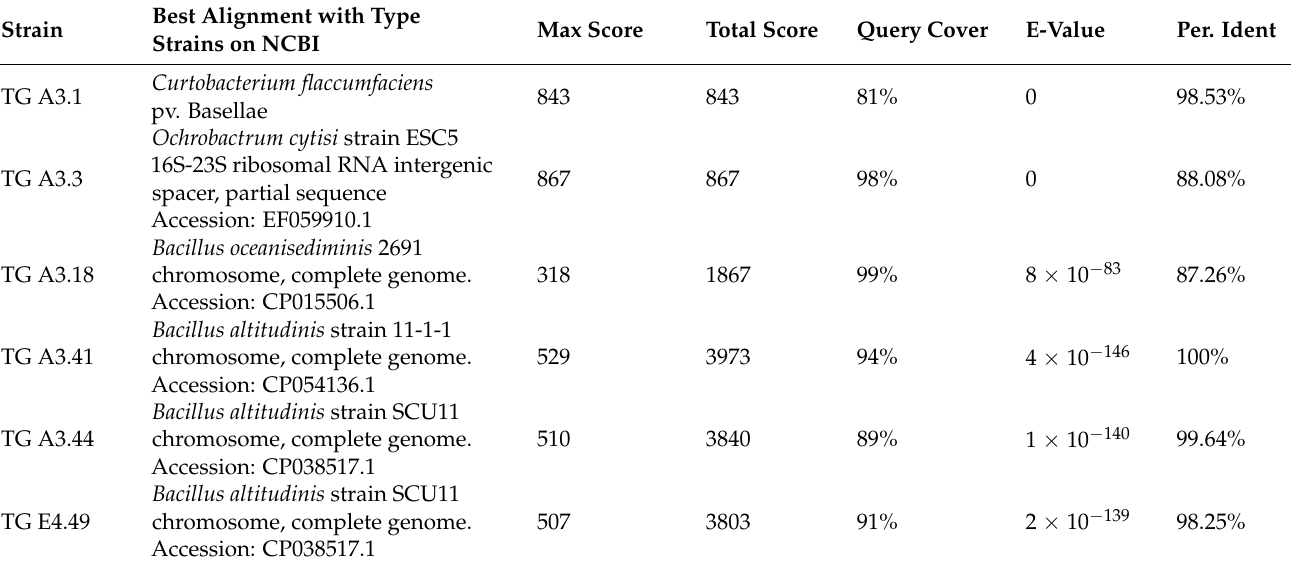
Table 4. Identification of T. grandis endophytic bacteria based on the BLAST analysis of the 16S-23S rDNA intergenic spacer (IGS)